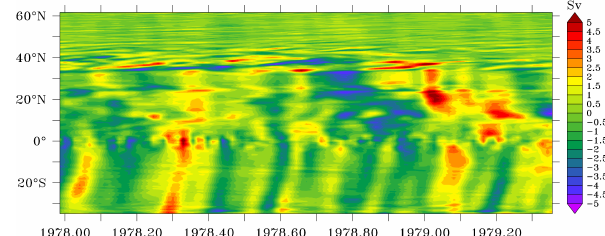
Figure 21: Propagation of chaotic MOC anomaly fluctuations in the Atlantic at 1000 m depth (eddy- Fig. 21. Propagation of chaotic MOC anomaly fluctuations in the permitting case). Atlantic at 1000m depth (eddy-permitting